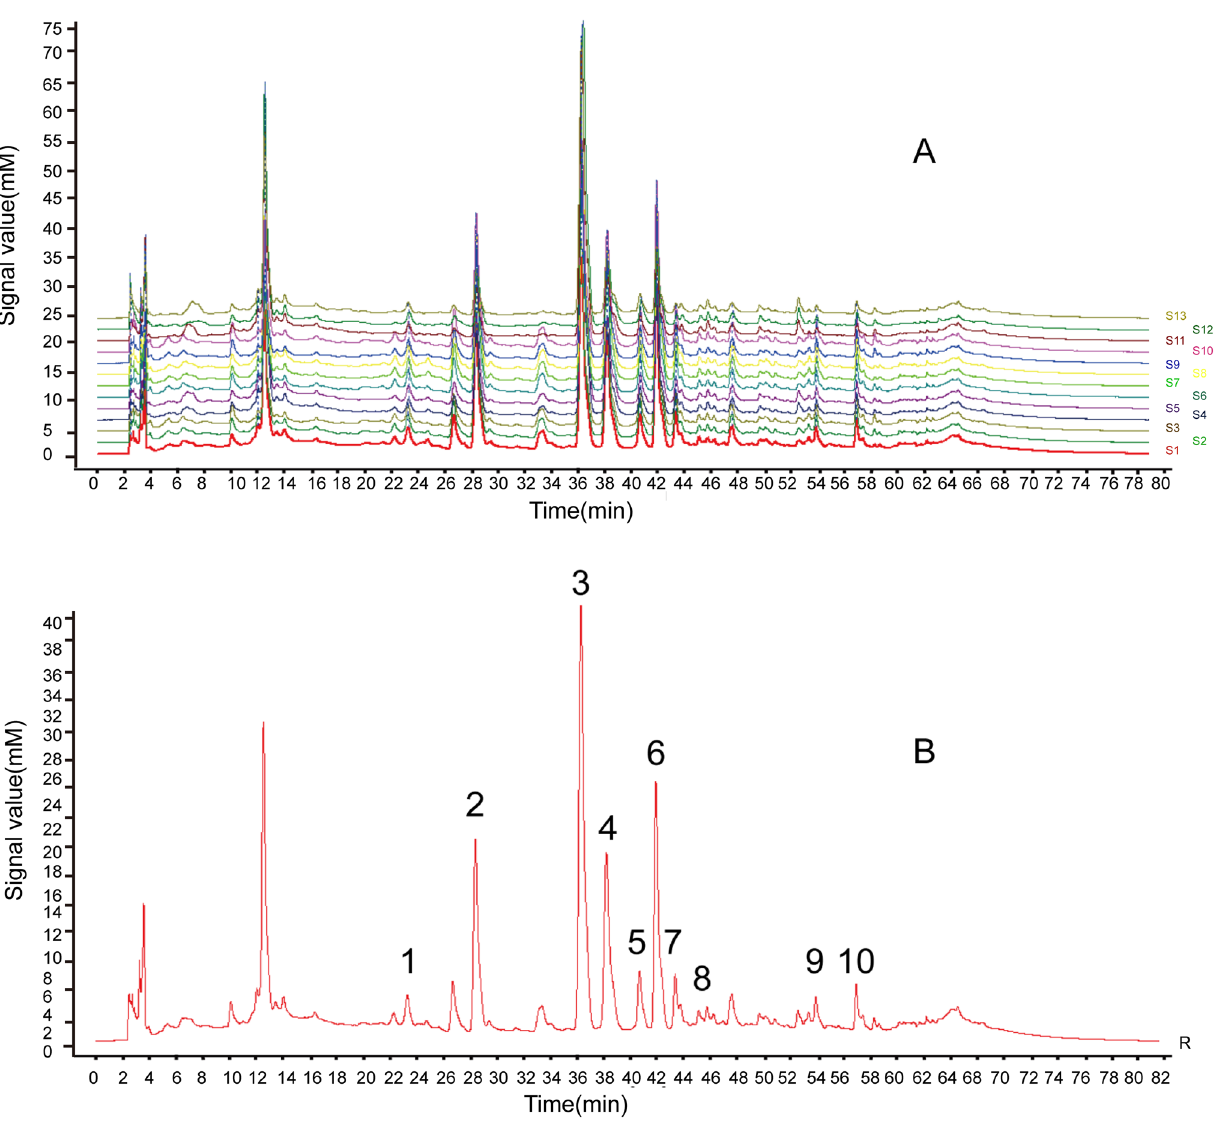
Fig. 1 High-performance liquid chromatography (HPLC) fingerprints of Antiuric Acid Formula (AAF). a HPLC fingerprints of AAF batches (S1– S13: AAF01–AAF13); b Comparative HPLC fingerprint of AAF (1–10: common